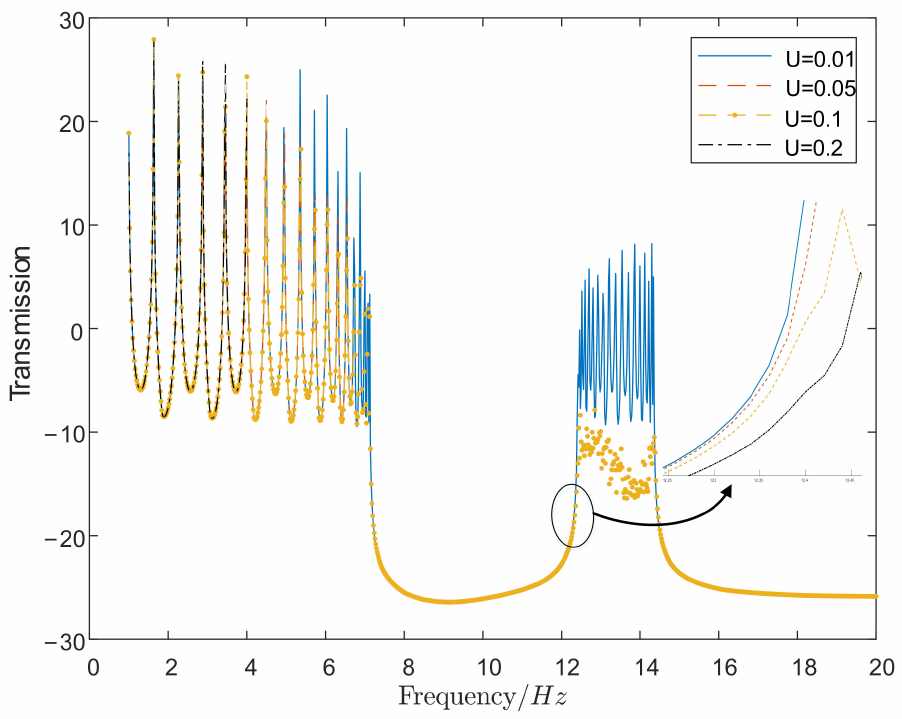
Figure 14. Influence of displacement excitation amplitude on band gap ( γ = 0.2; N = 20).